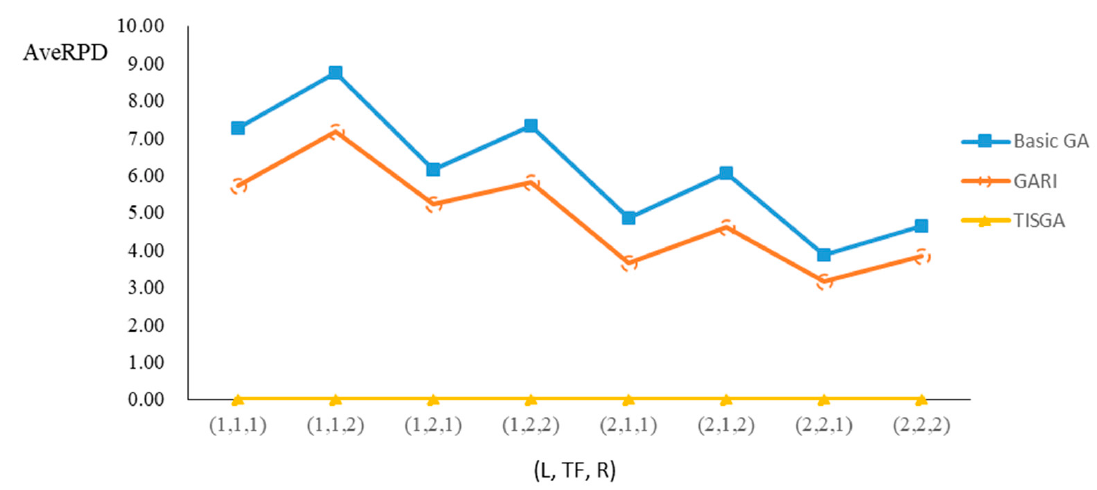
Figure 20. Comparison results for n = 200 with eight combinations of (L, TF, R).